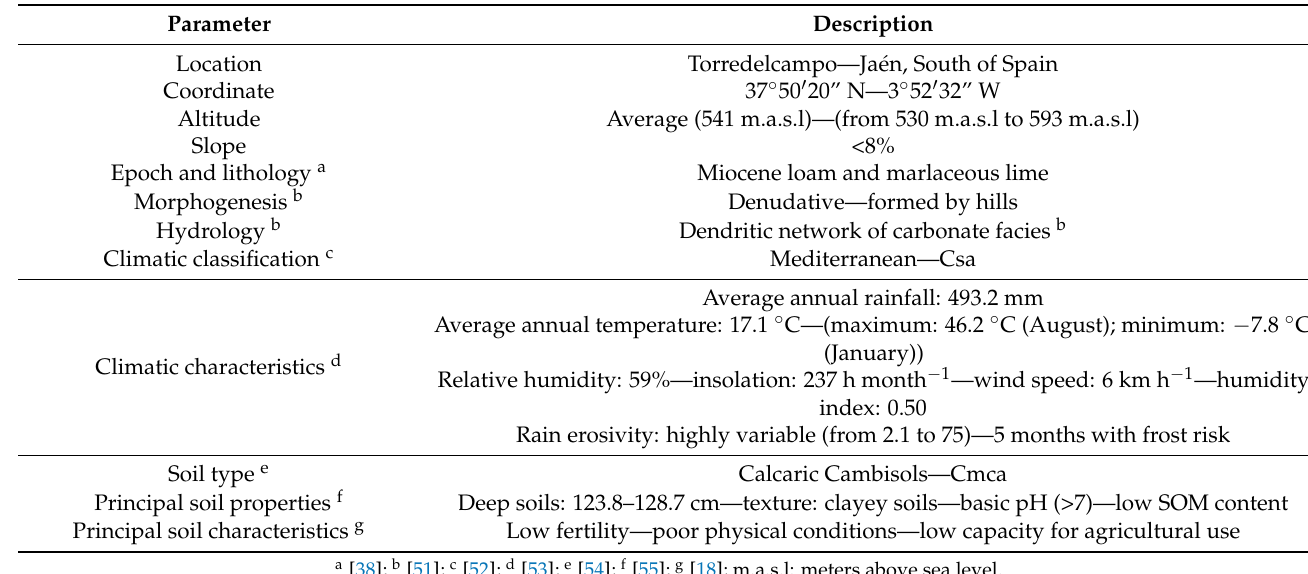
Table 1. Main characteristics of the study area.